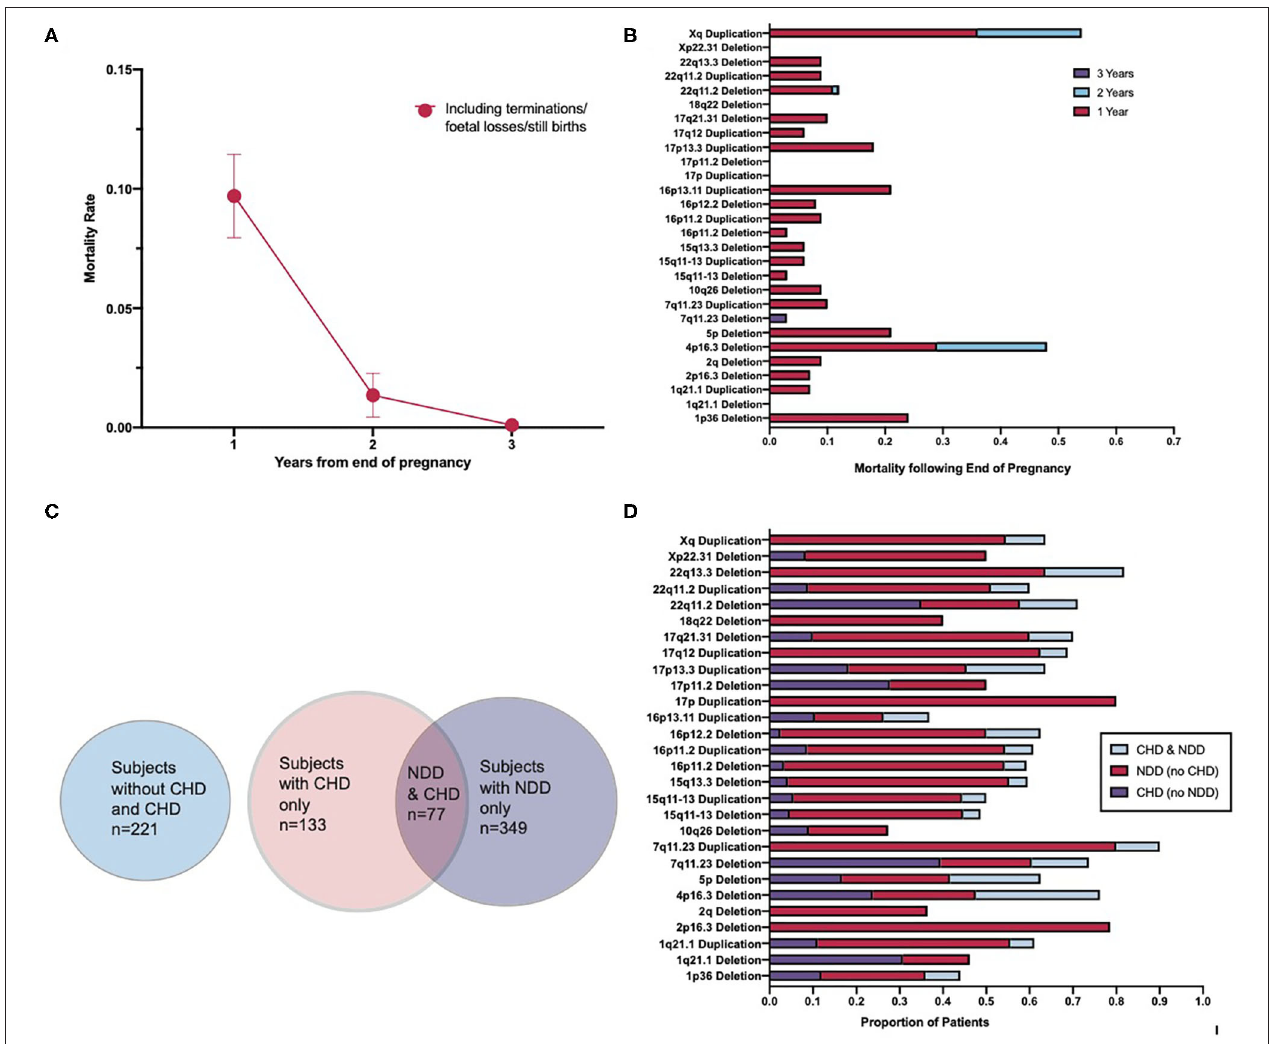
FIGURE 3 | Association of congenital heart disorders and neurodevelopmental disorders resulting from the pleiotropic effect of copy number variants. (A) Mortality rate of patients across a 3-year period following end-of-pregnancy. (B) Cumulative mortality over a 3-year period by CNV type. (C) Venn diagram illustrating the overlap in the number of CHDs and NDDs across the cohort, including a separate indicator of those patients with neither a CHD nor a NDD. (D) Percentage distribution of patients with CHDs, NDDs, and with both CHDs and NDDs across each CNV type. Spearman’s correlation test for global correlation between presence of CHD and presence of both CHD and NDD revealed a statistically significant positive correlation ( r = 0.6956, p < 0.0001). A two-way ANOVA test revealed the CNV type as a statistically non-significant factor in the correlation between the presence of CHD and both CHD and NDD [ F (27,27) = 1, p = 0.0686]. CNV, copy number variant; CHD, congenital heart disorder; NDD, neurodevelopmental